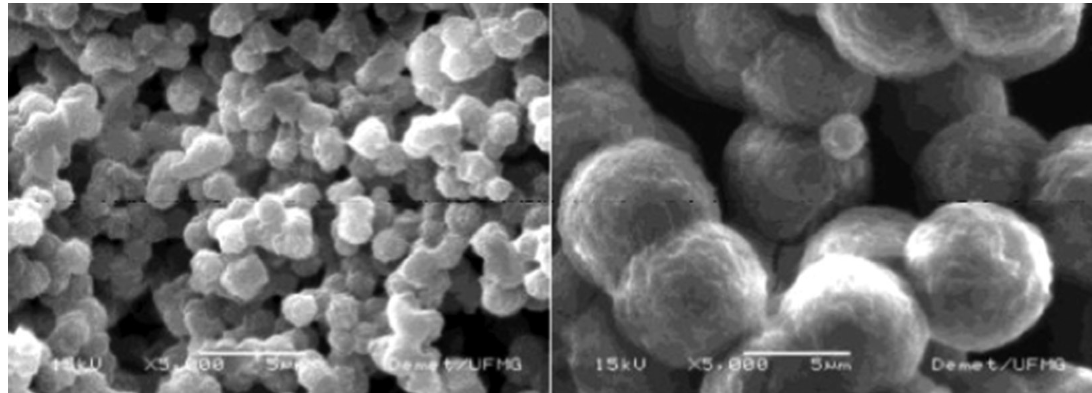
Figure 4. Fracture images of materials higher magnification of PVDF (left) and PVDF/PHEMA/LiClO